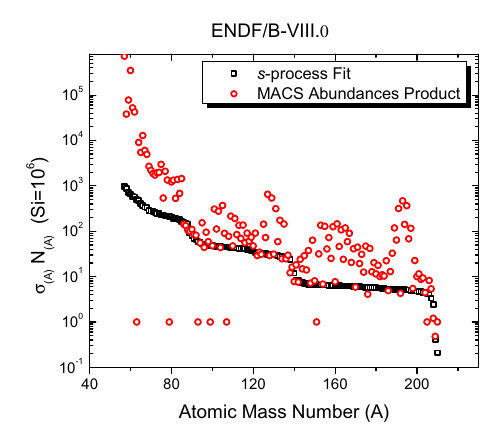
Figure 3. ENDF / B-VIII.0 and solar system r -process abun- dances that were deduced by M. Arnould et al. [36,